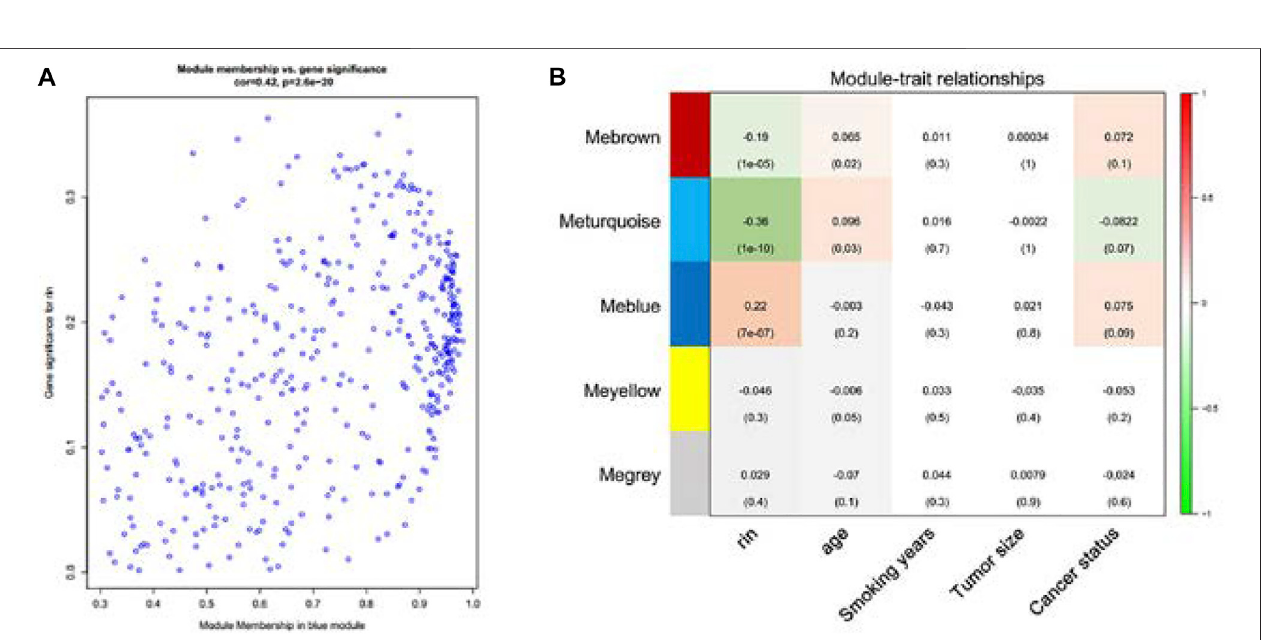
Frontiers in Genetics |